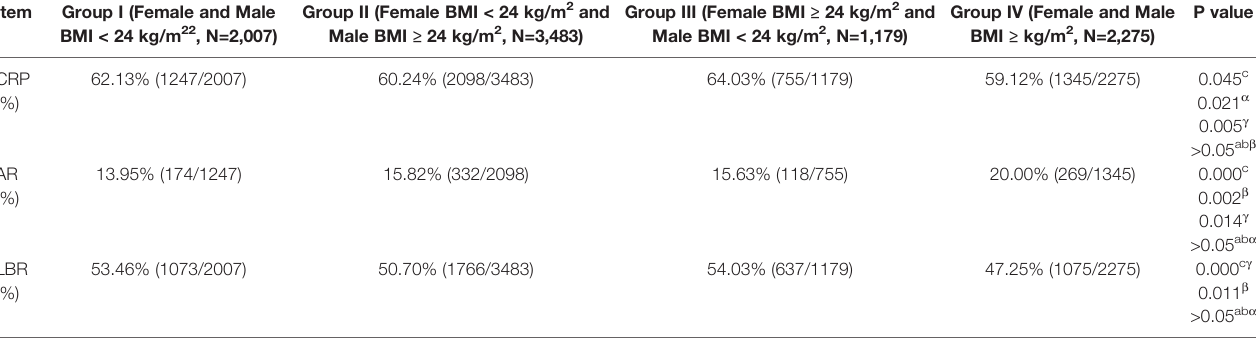
TABLE 3A | Effect of female and Male BMI on pregnancy outcome in IVF cycles.